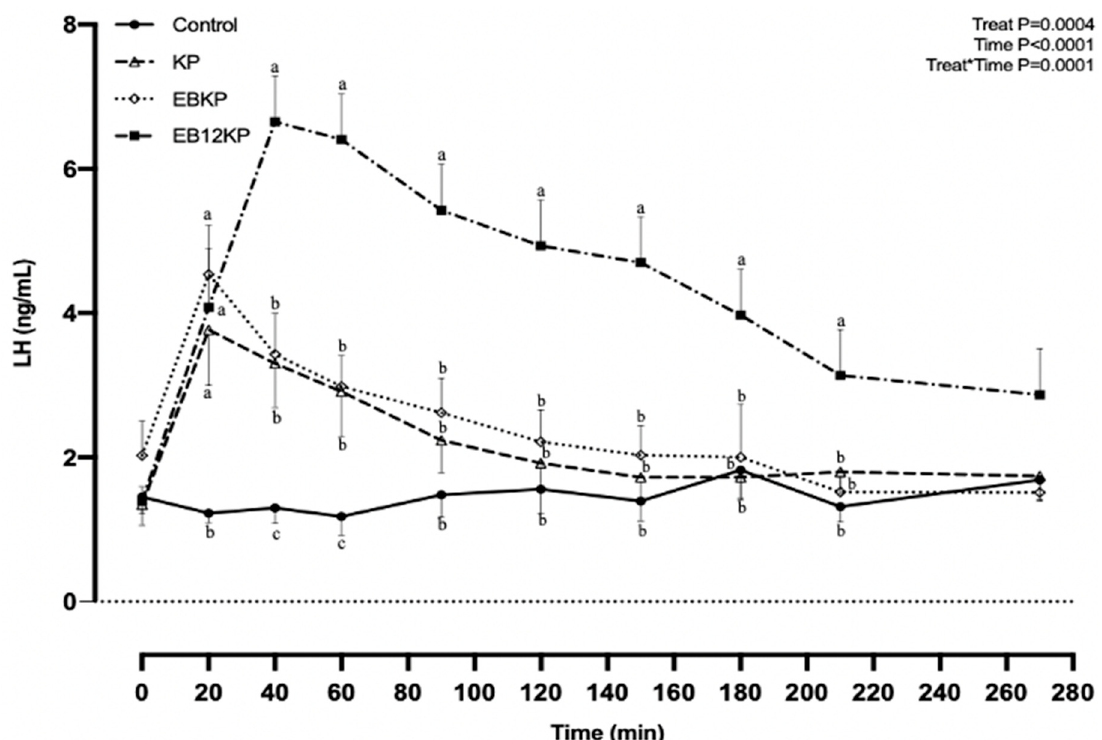
Figure 2. Plasma LH concentrations (means and sem) in ovariectomized Nelore cows ( n = 8) that received the following treatments: Control, i.m. 4 mL 0.9% saline (Control) at time 0 min; KISS1-10 (KP), i.m. 4 mg murine KISS1-10 in 4 mL 0.9% saline at time 0 min; EBKP, i.m. 4 mg KISS1-10 + i.m. 2 mg estradiol benzoate (EB) simultaneously at time 0 min; EB12KP, i.m. 2 mg EB 12 h before i.m. 4 mg KISS1-10 at time 0 min. Treatment, time, and treatment*time effects were highly statis- tically significant. a,b,c LH concentrations within time points without a common letter differ ( p < 0.05). Table 1. Parameters of LH release in ovariectomized Nelore cows treated i.m. with 4 mg murine KISS1-10 (KP); KISS1-10 + i.m. 2 mg estradiol benzoate simultaneously (EBKP); and KISS1-10 + i.m. 2 mg EB 12 h before KISS1-10 (EB12KP). AUC (LH ng/mL*min), area under the LH-response curve; ∆ LH (ng/mL), highest LH concentration minus the LH concentration at time 0 min (treat- ment). Results are means ± sem.